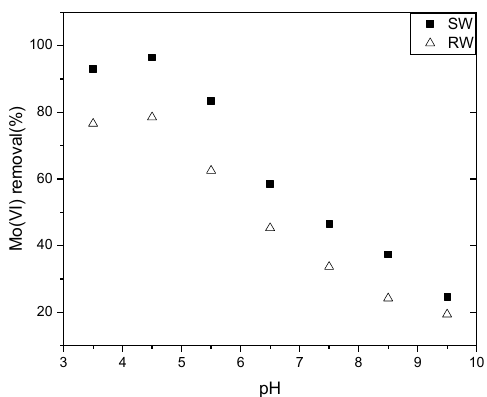
Figure 3. E ff ects of varying equilibrium pH values on Mo(VI) adsorption. Conditions: solid / liquid = Figure 3. Effects of varying equilibrium pH values on Mo(VI) adsorption. Conditions: solid/liquid = 0.5 g / L, T = 298 K, initial Mo concentration in simulation water = 0.1603 mg / L; initial Mo concentration 0.5 g/L, T = 298 K, initial Mo concentration in simulation water = 0.1603 mg/L; initial Mo concentration in raw water = 0.1603 mg / in raw water = 0.1603 mg/L.